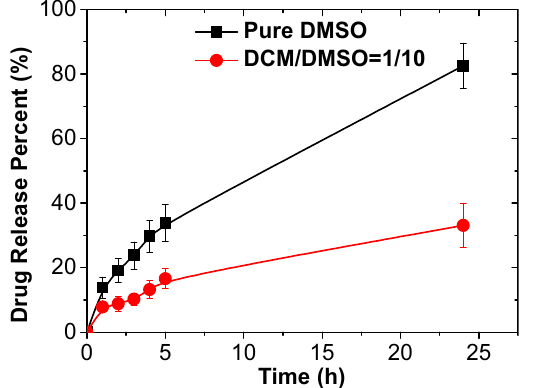
Figure 7. Comparison of the in vitro doxorubicin (DOX) cumulative release profiles using PLGA NPs obtained at different V DCM /V DMSO